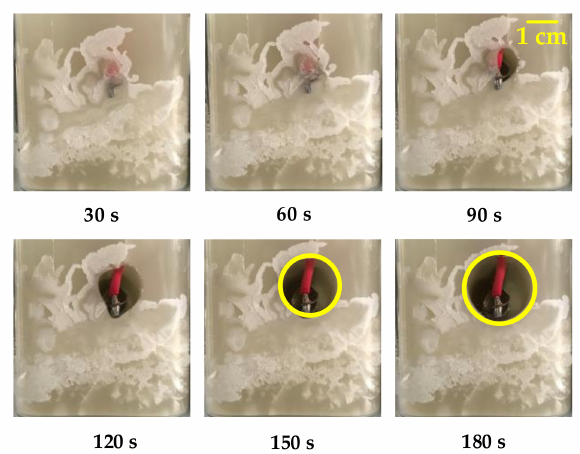
Figure 9. Melting process (0–180 s at 50 W